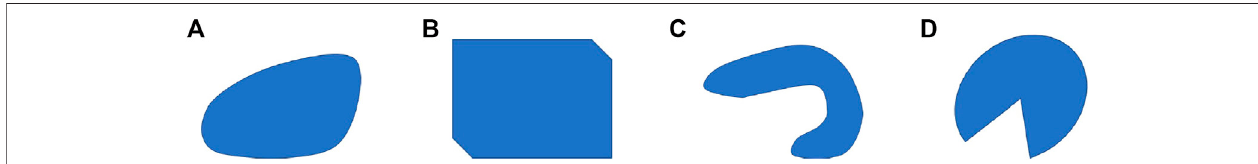
FIGURE 2 | The environment considered in the paper can consists of any of the following obstacles: (A) a smooth convex obstacle, (B) a non-smooth convex obstacle, (C) a smooth concave obstacle, and (D) a non-smooth concave obstacle.